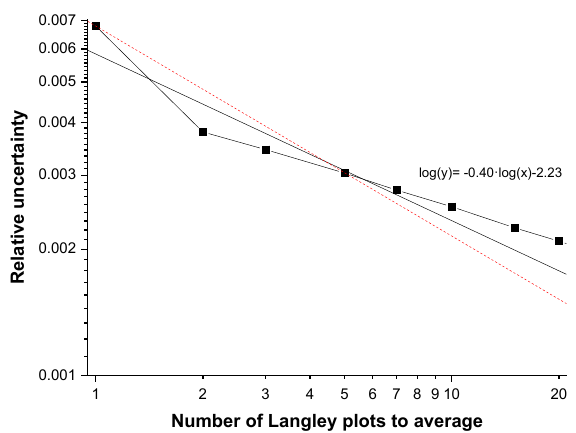
Figure 6. Uncertainty of the Langley plot calibration vs. number of Langley plot V 0 ’s that are averaged, using GAW-PFR data (500nm) at Mauna Loa (2000–2014). The black line indicates the fit to the ex- perimental data in log–log scale (fit result provided). The red dashed line indicates the theoretical decrease in uncertainty with the square root of the number of